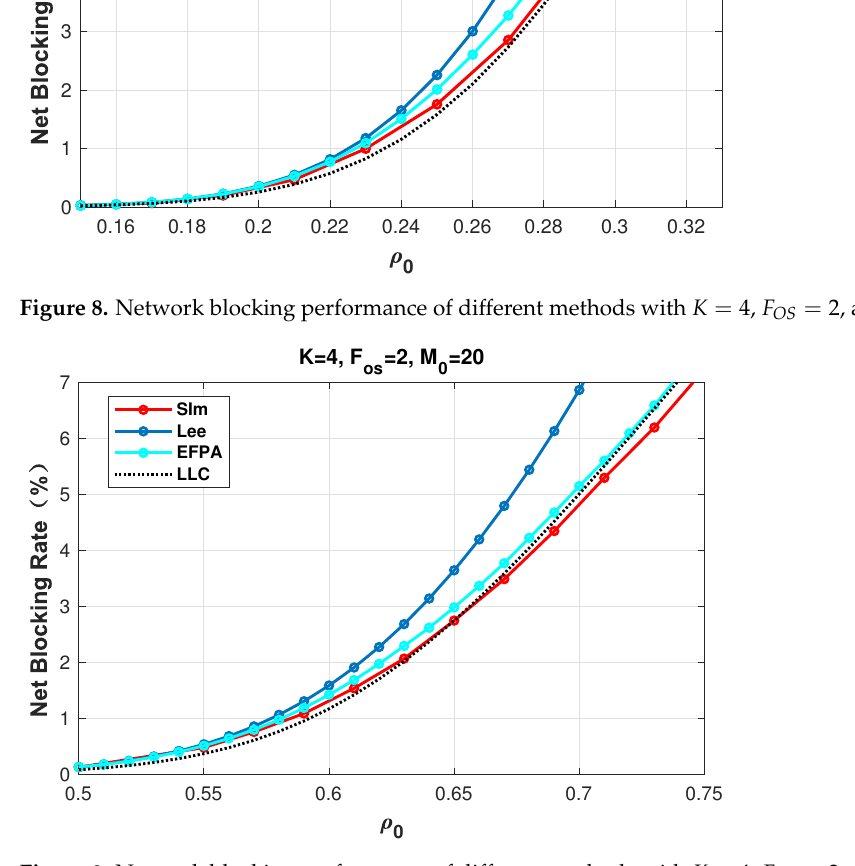
Figure 9. Network blocking performance of different methods with K = 4, F OS = 2, and M 0 = 20.